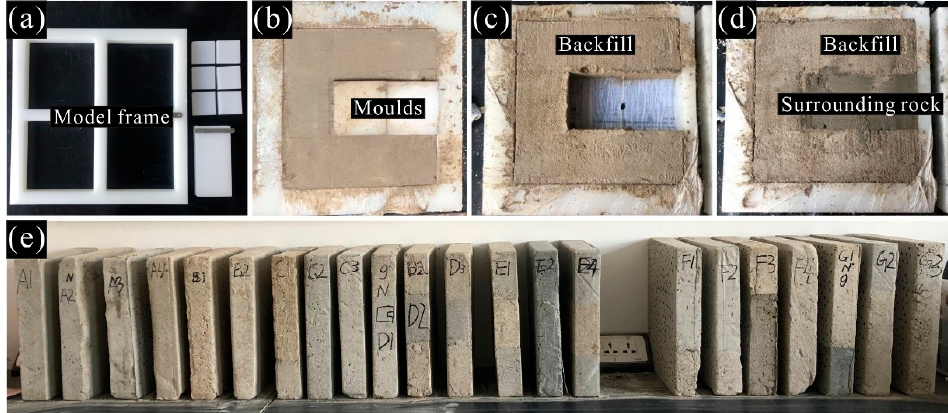
Figure 7. Physical model samples. ( a ) Model frame; ( b ) molds; ( c ) strain field; ( d ) acoustic emission energy; ( e ) acoustic emission